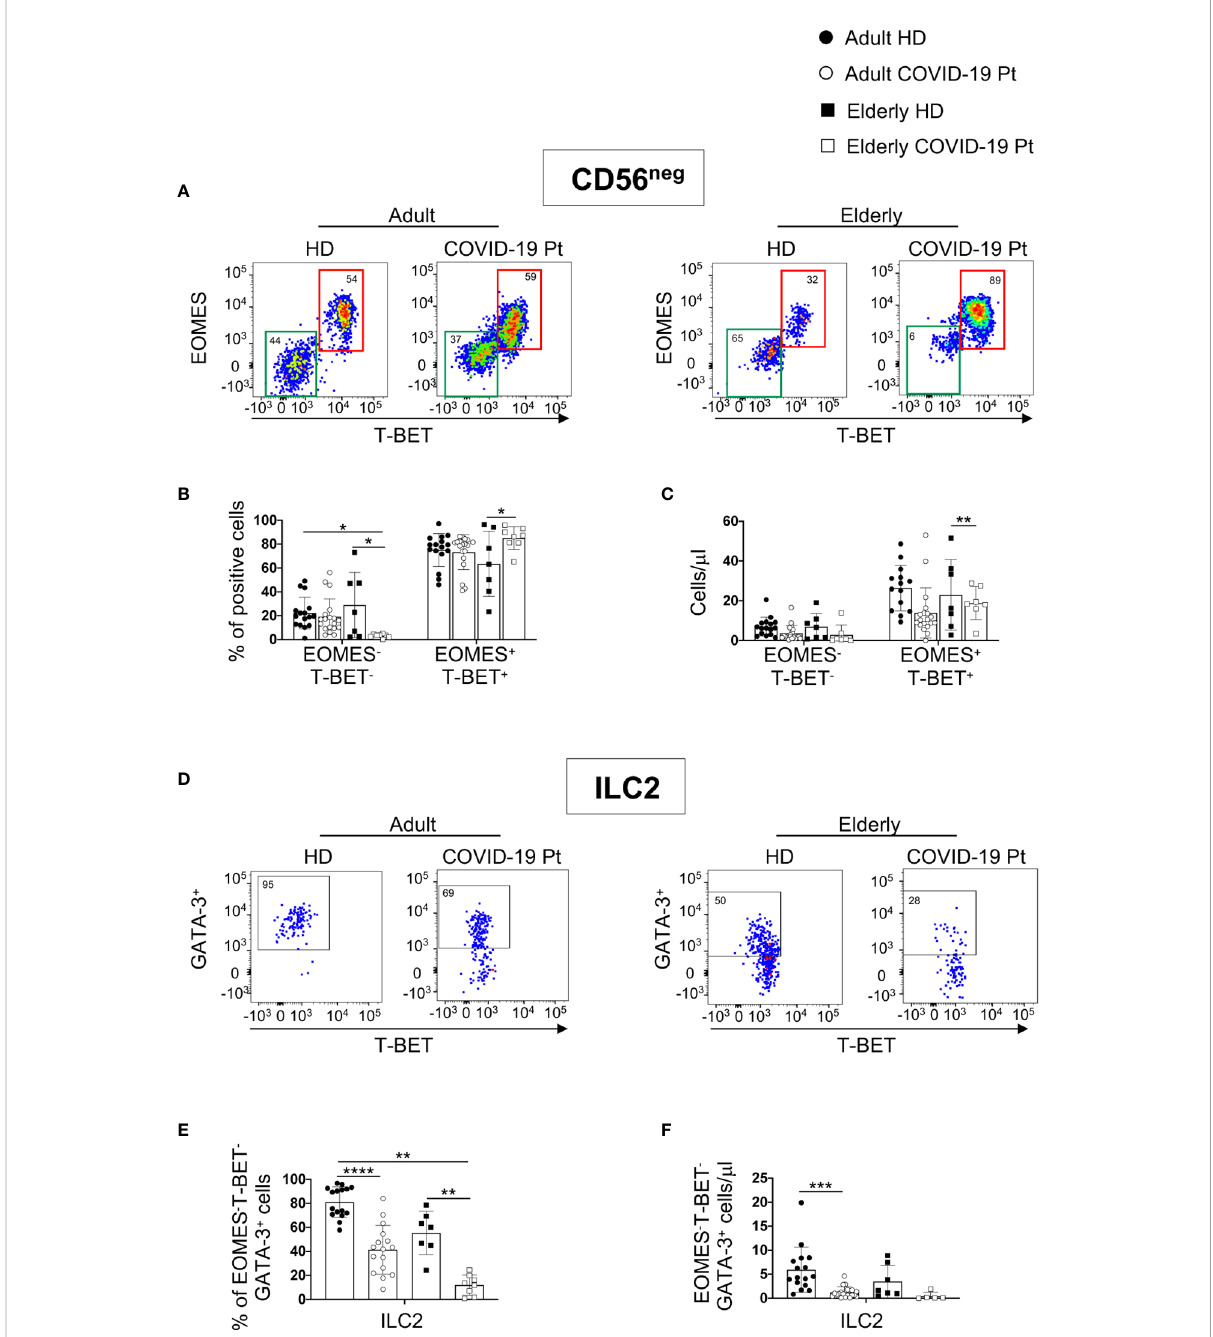
FIGURE 4 Alterations in circulating CD56 neg cells in adult and elderly COVID-19 patients at hospital admission. Gating strategies used to identify EOMES - T-BET - and EOMES + T-BET + subsets within CD56 neg cells (A) and ILC2 among EOMES - T-BET - cells (D) and their relative frequency are shown on a representative adult and elderly COVID-19 patient and age-matched controls. Lin - CD45 + CD7 + CD56 - cells were analyzed for the expression of transcription factors EOMES and T-BET. ILC2 were identi fi ed within EOMES - /T-BET - CD56 - cells as EOMES - T-BET - GATA3 + . Percentage and absolute counts of CD56 - EOMES - /T-BET - and EOMES + T-BET + (B, C) and ILC2 (E, F) are reported. Histograms show mean ± SD. * p< 0.05, ** p< 0.01, *** p< 0.001, **** p< 0.0001. Two-way analysis of variance (ANOVA) Tukey ’ s multiple comparisons test and One way ANOVA Kruskal-Wallies test multiple